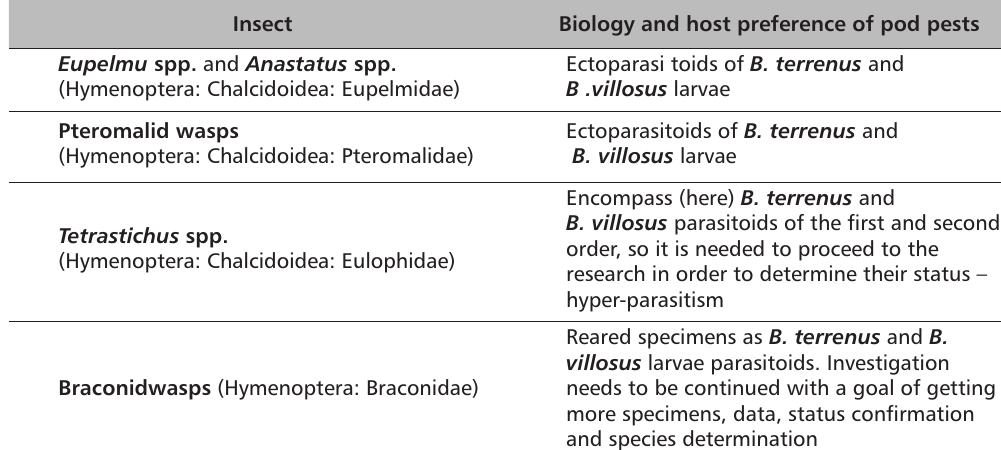
TABLE 3. Parasitoid complex as potential biological threatening agents for seed